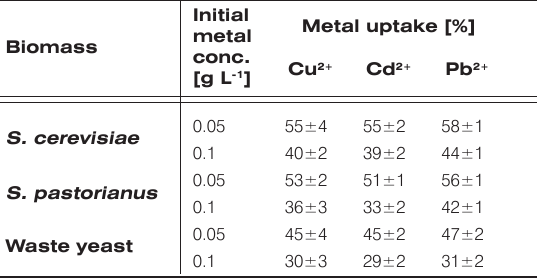
Table 3. The heavy metal uptake capacities of different biomass